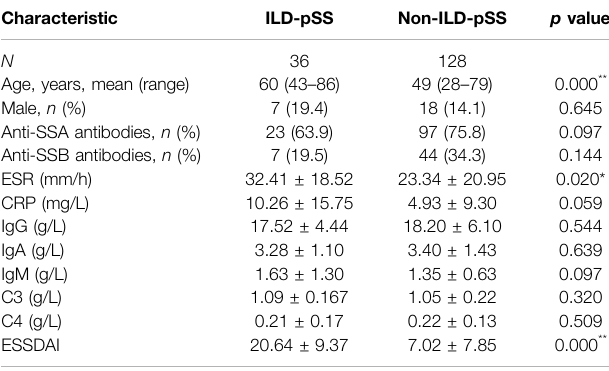
TABLE 1 | Clinical characteristics of patients with ILD-pSS and non-ILD-pSS.